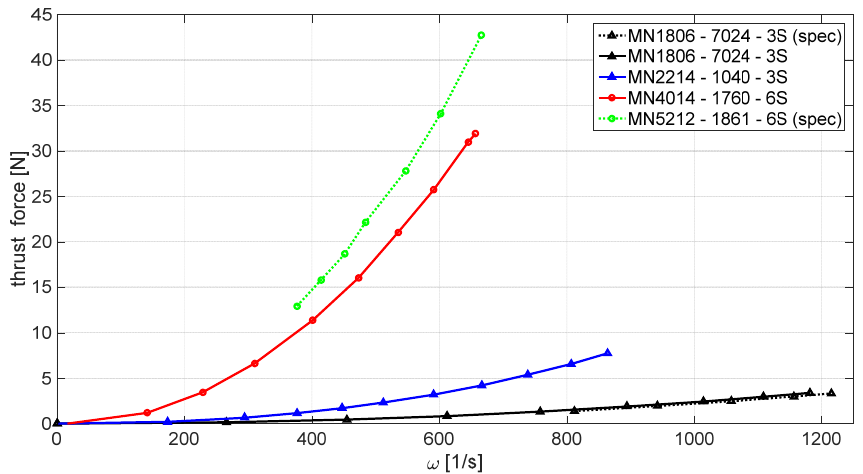
Figure 23. Thrust force with respect to the rotor angular velocity of selected EPU setups.